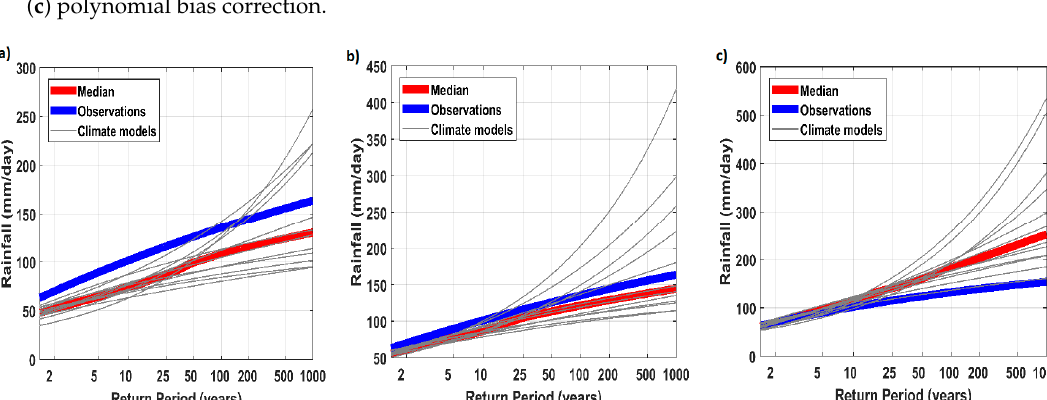
Figure 6. Annual maximum daily precipitation frequency curves in Porma catchment. Red lines represent the median of the 12 climate models considered. ( a ) Raw precipitation supplied by climate models; ( b ) linear bias correction; ( c ) polynomial bias correction.